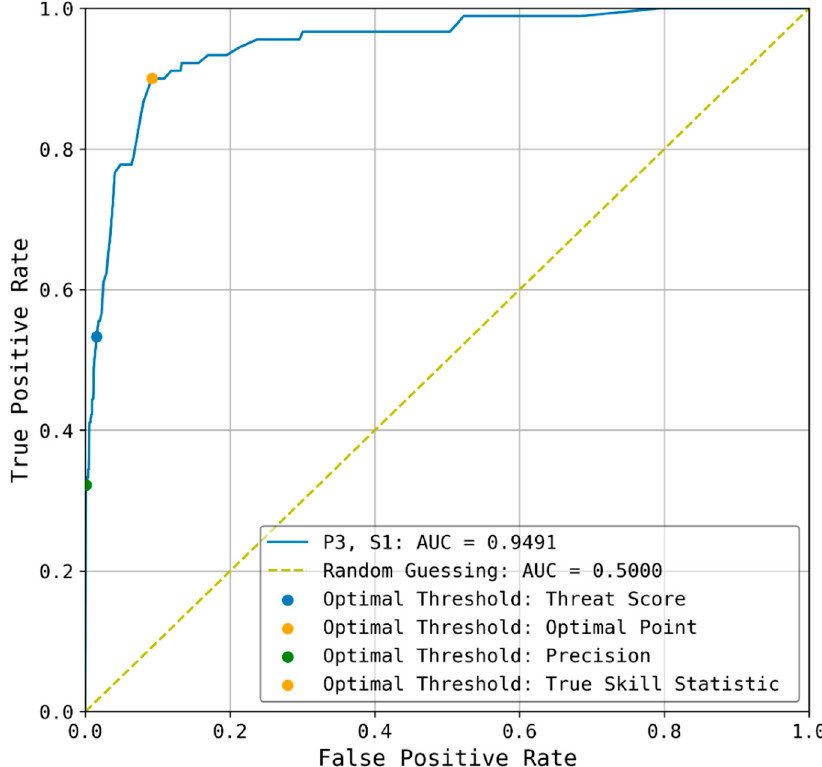
Figure 2. HydroMet output plot showing optimal ROC curve for Portland, OR, using 3-days recent cumulative precipitation (P3) and 1-day antecedent saturation (S1). Each skill statistic was optimized on a range of threshold values. The skill statistics were tested for cumulative precipitation and antecedent saturation between 1 and 15 days. The resulting optimal daily threshold is shown. Optimal point and true skill statistic had the same optimal true positive rate and false positive rate, shown in orange.